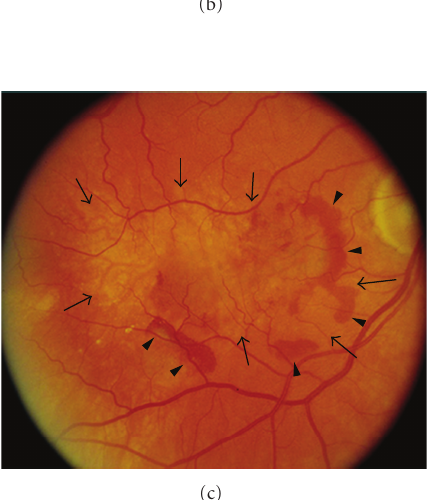
Figure 2: (a) Fundus photo of the right eye with early non- neovascular (dry) AMD. Note the numerous yellow subretinal deposits (Drusen). (b) Fundus photo of the right eye with advanced nonneovascular AMD (Geographic atrophy). Note area where RPE cells have died from apoptosis (arrowheads). (c) Fundus photo of the right eye with neovascular or wet AMD. Note subretinal hemorrhage (arrowheads) adjacent to a choroidal neovascular membrane